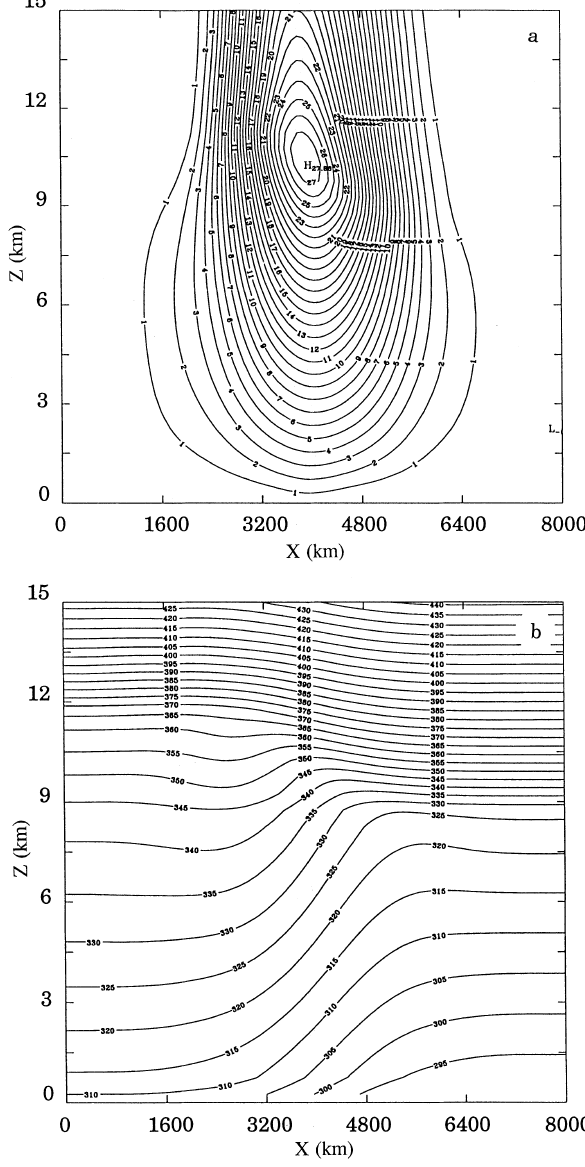
Fig. 13a,b. Basic state used for the baroclinic wave control simulation. a Meridional cross-section of the zonal wind, contour interval 1m s (cid:255) 1 ; b potential temperature, contour